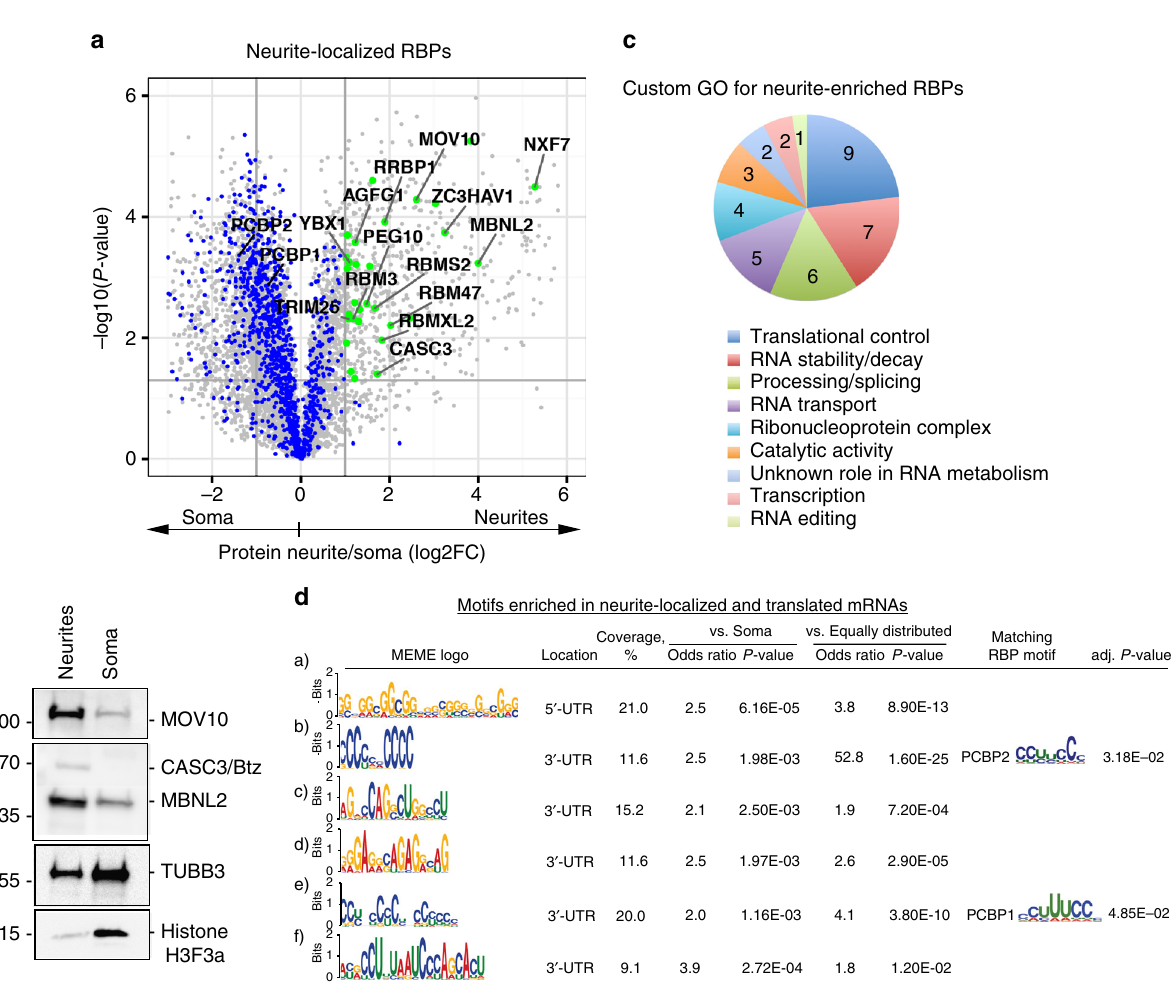
Fig. 6 A subset of RBPs localizes to neurites. a Neurite-localized RBPs. Proteomic data from Fig. 1e were overlaid with available databases of mRNA-bound proteins 48 – 51 . Neurite-localized RBPs are highlighted in green (protein neurite/soma log2FC > 1, P -values < 0.05; see also Supplementary Data 2), the rest of RBPs are shown in blue . b Western blot validation for selected neurite-enriched RBPs. Histone H3 and TUBB3 were used as soma-enriched markers. c Manual annotation of neurite-enriched RBPs (protein neurite/soma log2FC > 1 and P -values < 0.05) for RNA-related functions. Number of proteins in a given category is indicated on the pie chart. Some RBPs were annotated to multiple GO categories. See also Supplementary Data 7. d Motifs found in mRNAs localized to neurites and locally translated. Motif discovery was done with MEME 56 and enrichment calculations with MAST 57 . Fisher ’ s exact test was used to assess statistical signi fi cance of the association and its enrichment (odds ratio). Alignment of known RBP target sites 70 (not restricted